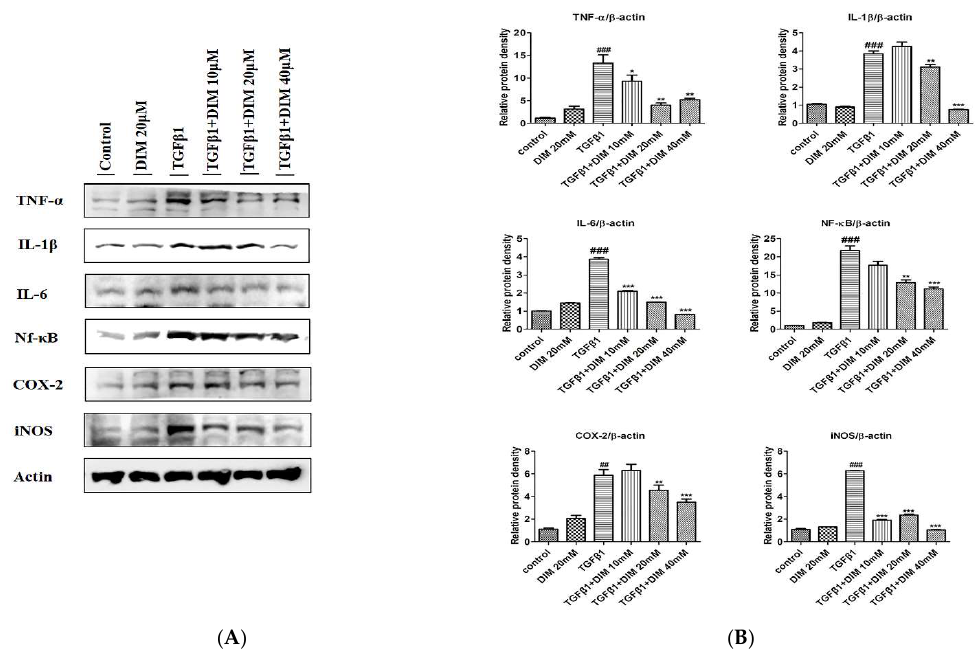
Figure 5. Anti-inflammatory effects of DIM on TGF- β 1-induced injury of hepatocytes. ( A ) Western blot analysis revealed anti-inflammatory response of DIM in AML12 cells after TGF- β 1 treatment for 24 h. ( B ) Quantification of relative density of inflammatory-related proteins expression normalized to β -actin. Data are mean ± SE of three separate experiments. ## p < 0.01; and ### p < 0.001 denotes significant differences compared to the control; *, p < 0.05; **, p < 0.01; and ***, p < 0.001 compared to treatment with TGF- β 1 only.